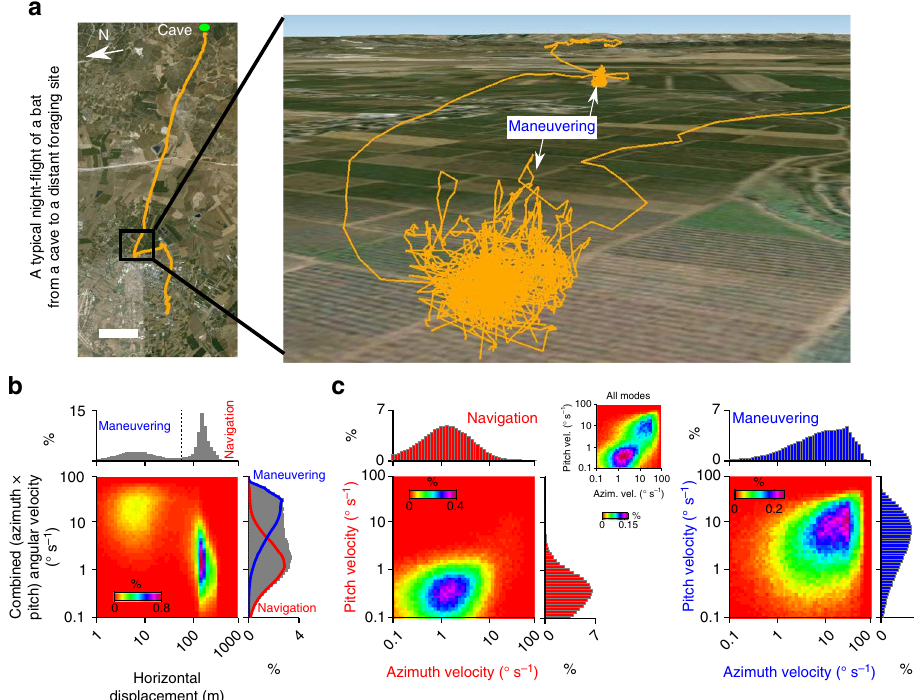
Fig. 5 Bat orientation behavior consists of two distinct modes — navigation and maneuvering — that are characterized by different angular speeds. a Left, a typical night- fl ight of an Egyptian fruit bat from its roosting cave (green ellipse) to distal foraging sites; scale bar, 2 km. Right, a zoom-in on the natural orientation behavior, showing epochs of navigation (commuting) — characterized by relatively straight fl ights during which there was little modulation of heading-direction, interspersed by periods of intensive maneuvering around fruit-trees (indicated by white arrows) — characterized by rapid turns (imagery produced using desktop version of Google Earth Pro). b Distribution of the combined (azimuth × pitch) angular velocity versus horizontal displacement of the bat. Maneuvering mode and navigation mode were classi fi ed according to the threshold (vertical dashed black line) at the minimum of the marginal distribution of the horizontal displacement. The marginal distribution of combined angular velocity is shown for all data (grey), and separately for navigation (red) and maneuvering modes (blue). c Angular-velocity distribution computed separately for pitch versus azimuth during navigation (left) and maneuvering (right). Inset (middle) shows the angular velocity distribution for the entire session. Note that during maneuvering (right), angular velocities in azimuth and pitch were correlated, suggesting that bats ’ maneuvers were composed of rapid rotations in both azimuth and pitch. The data in b and c were pooled over all bats and fl ights that we recorded (45 bats with one nightly fl ight for each bat 26